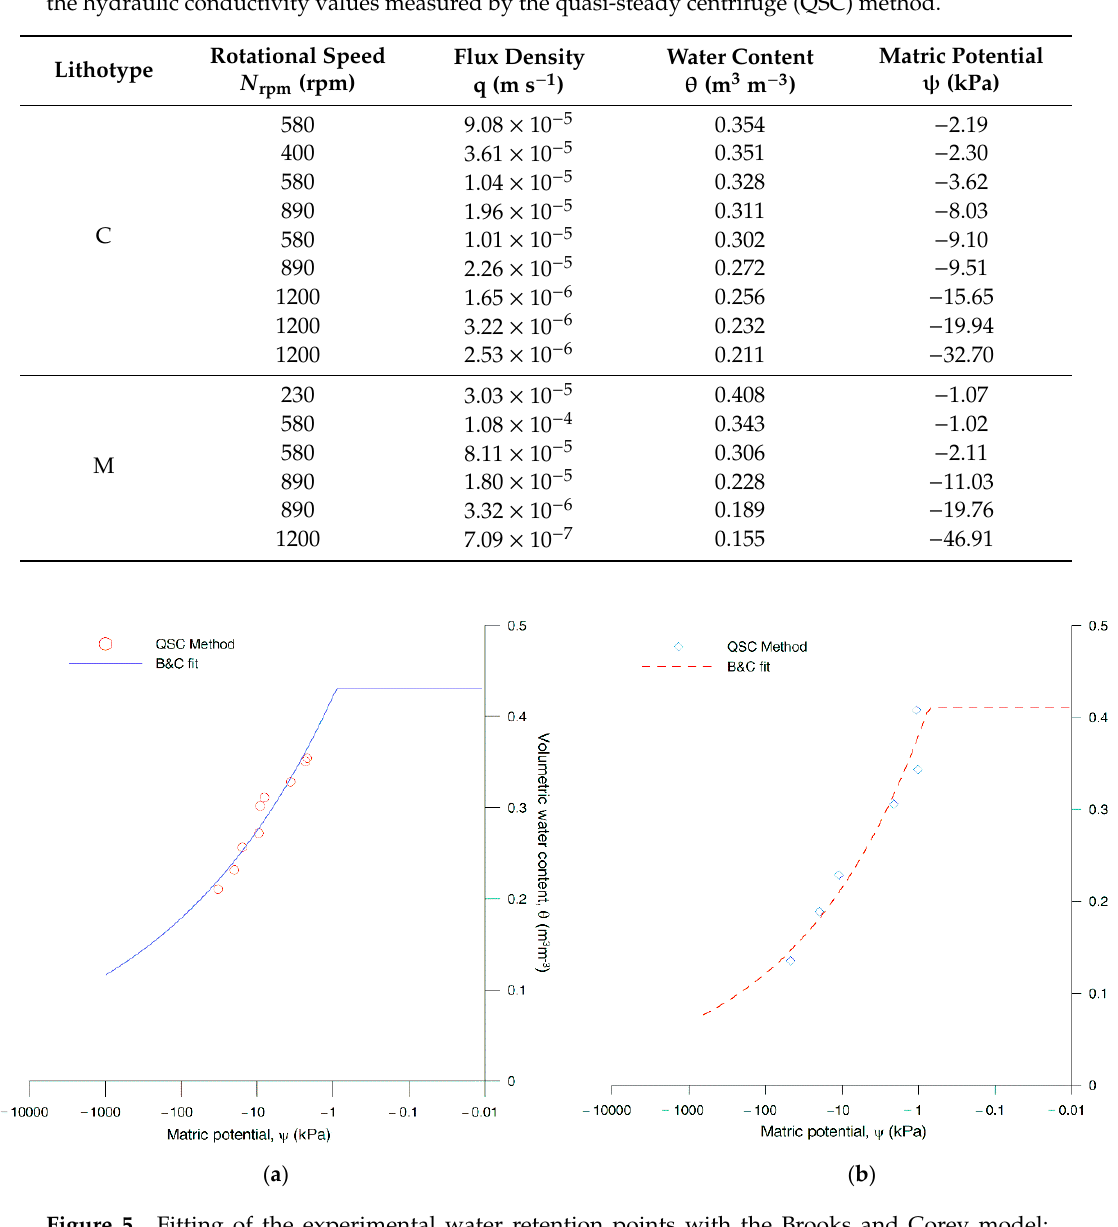
Table 2. KOPCEN input data to obtain the curves in Figures 5–7. The input data refer to the points of the hydraulic conductivity values measured by the quasi-steady centrifuge (QSC) method.